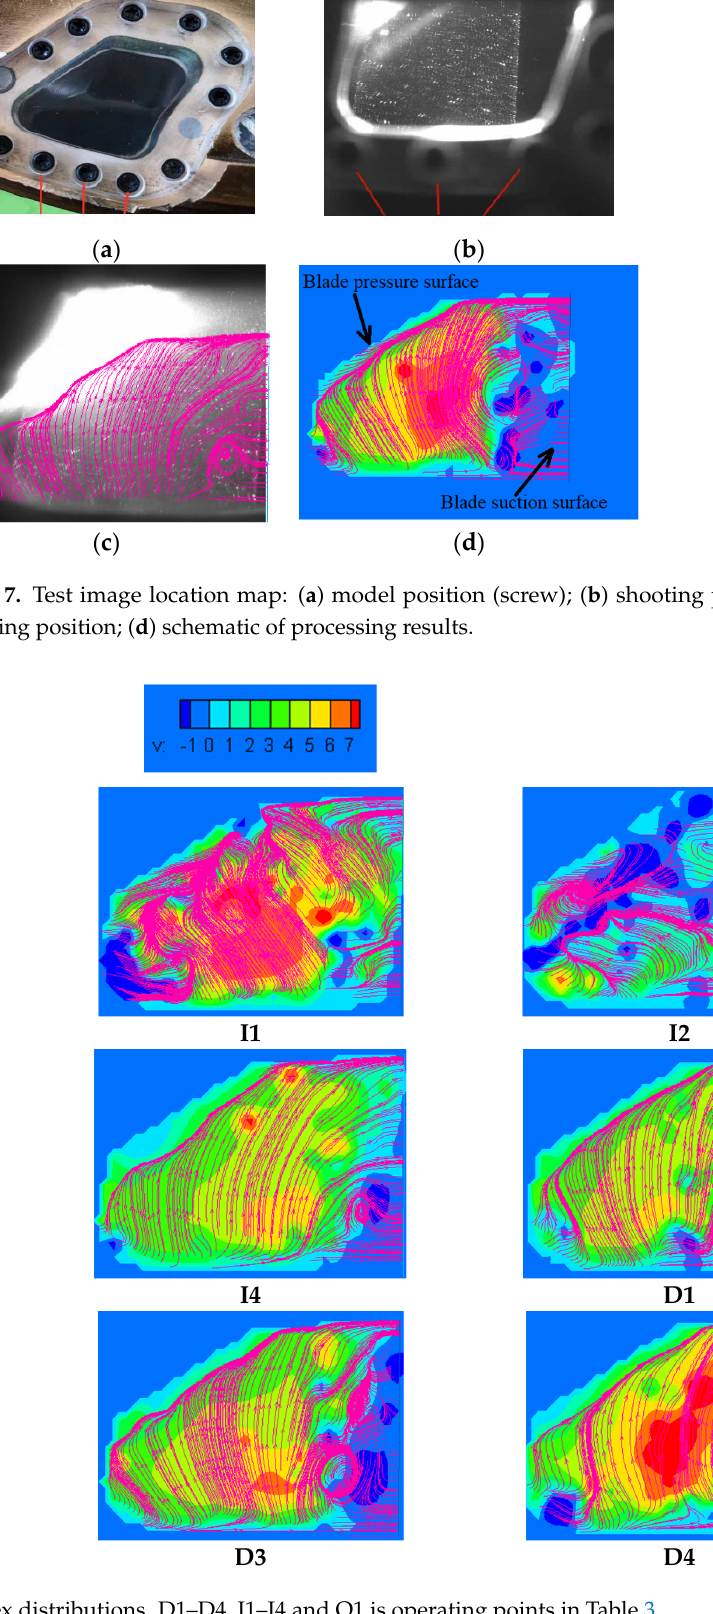
Figure 8. Vortex distributions. D1–D4, I1–I4 and O1 is operating points in Table 3